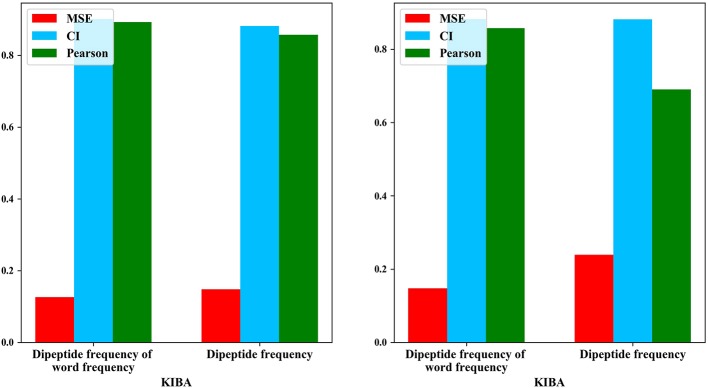
Comparison results of dipeptide features.